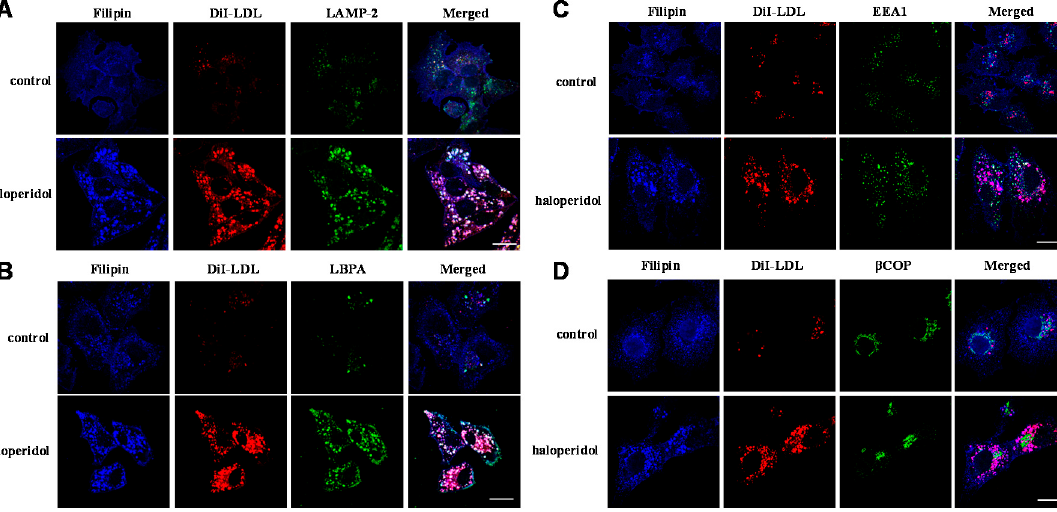
Figure 1. Effects of first-generation antipsychotic (FGA) haloperidol on the accumulation of low-density lipoprotein (LDL)-derived lipids in the late endosomal/lysosomal compartment. Untreated HepG2 cells (control) and cells treated for 16 h with 10 µM haloperidol were incubated with DiI-LDL (30 µg/mL of cholesterol), then were fixed and stained with filipin (free cholesterol): ( A ) cells stained for lysosome-associated membrane protein 2 (LAMP-2) (endo-lysosomes); ( B ) cells stained for LBPA (endo-lysosomes); ( C ) cells stained for early endosome antigen 1 (EEA1) (early endosomes); and ( D ) cells stained for coatomer subunit β ( β -COP) (Golgi). ( A – D ) Cells were photographed using a confocal microscope. Scale bar, 10 µm. Micrographs from a single representative experiment, of the three independent experiments performed, are shown.